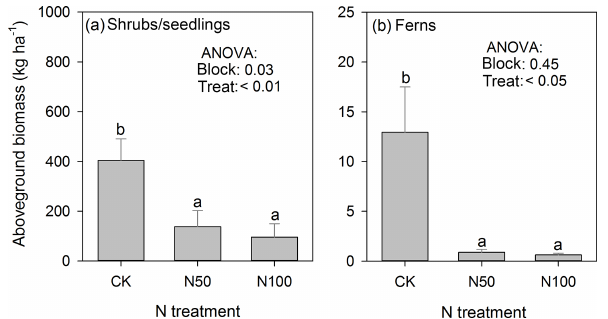
Figure 5. Effects of N fertilization on the aboveground biomass of shrubs, seedlings and ferns. Bars show the aboveground biomass of (a) shrubs/seedlings and (b) ferns (mean ± SE). Num- bers in these figures indicate the results of ANOVA. The N treatment on the x axis represents three levels of N fertiliza- tion: CK (0kg Nha − 1 yr − 1 ) , N50 (50kg Nha − 1 yr − 1 ) and N100 (100kg Nha − 1 yr − 1 )